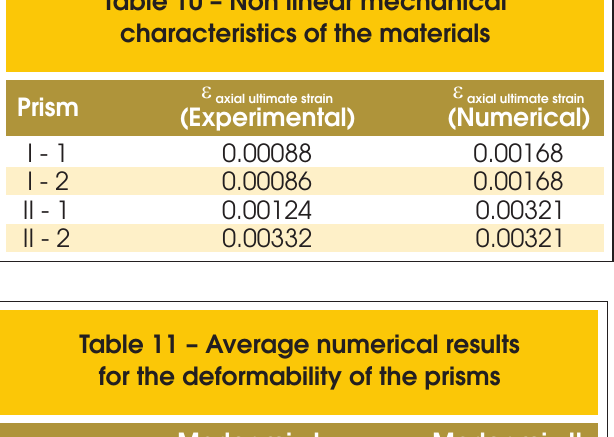
Figure 18 – Relation between the stresses of the numerical model for the mortar